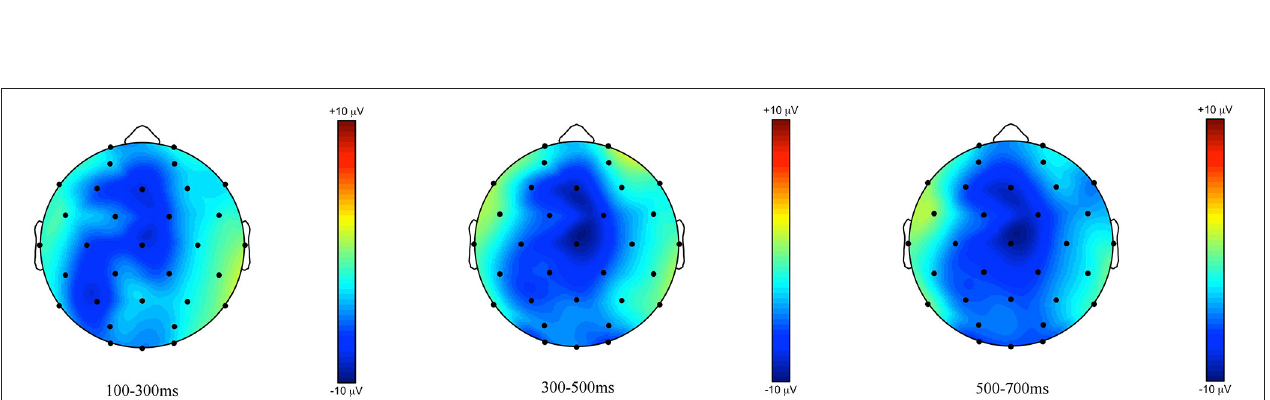
FIGURE 4 | Topographic maps of the ERPs recorded in children, time-locked to the presentation of the word “Ein paar” ( some ) for the some -infelicitous condition minus the some -felicitous condition in the three time windows.